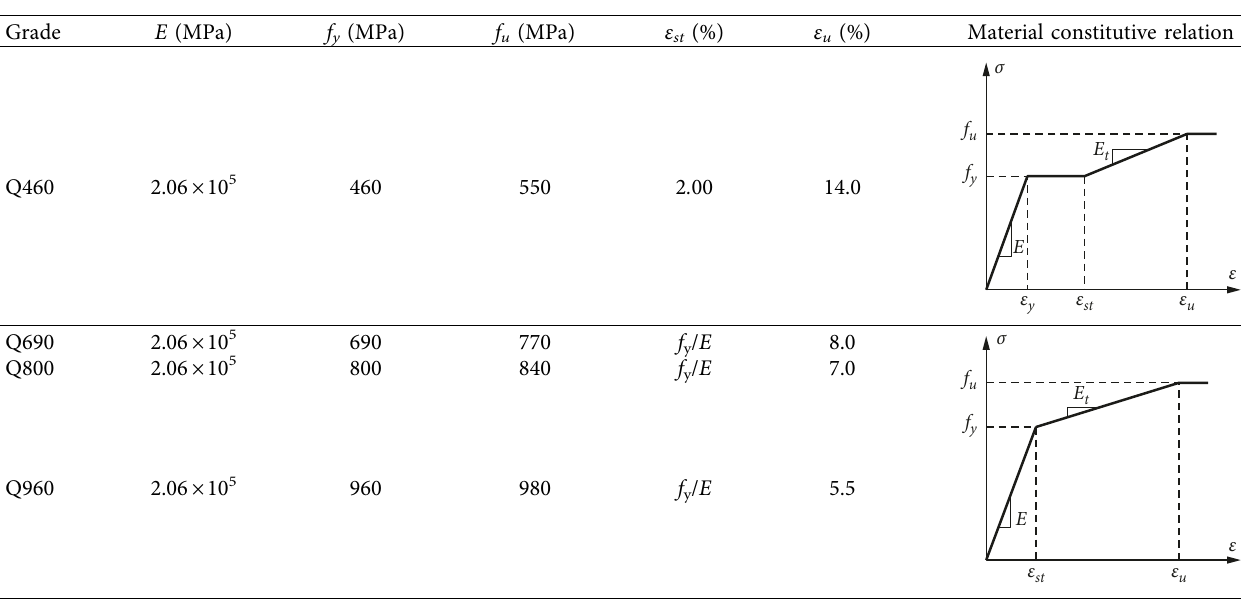
Figure 2: Typical finite element model: (a) boundary condition; (b) typical deformation. Table 1: Parameters for constitutive model of